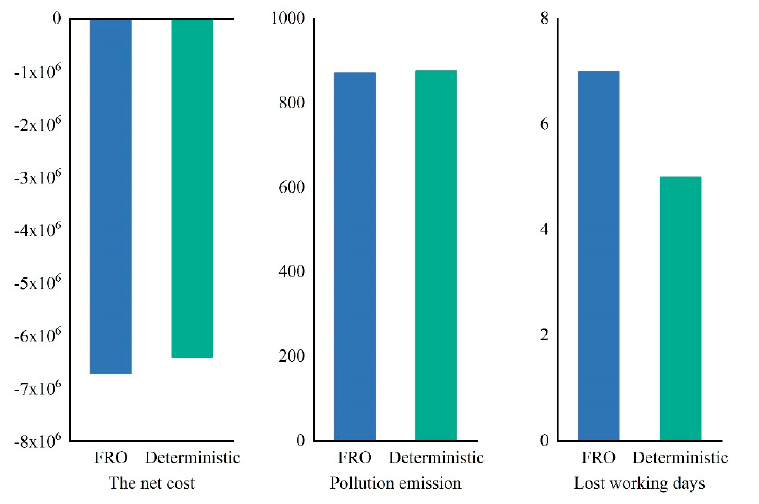
Figure 7. The comparisons of objective functions based on FRO and deterministic model with NSGA-II.